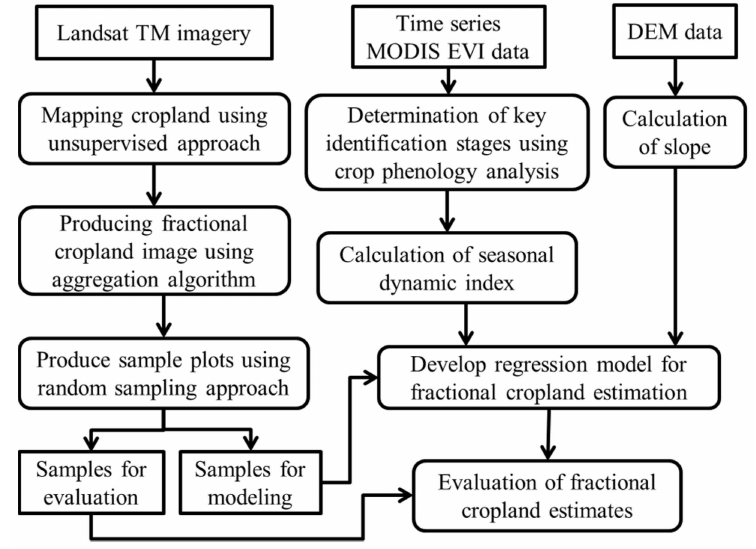
Figure 2. Framework of fractional cropland mapping approach using the integration of time series MODIS (Moderate-resolution Imaging Spectroradiometer) Enhanced Vegetation Index (EVI) and Landsat Thematic Mapper (TM)